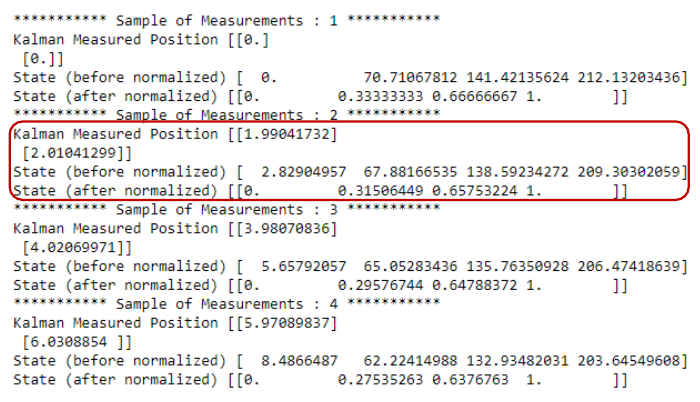
Figure 6. Some samples of measurement during